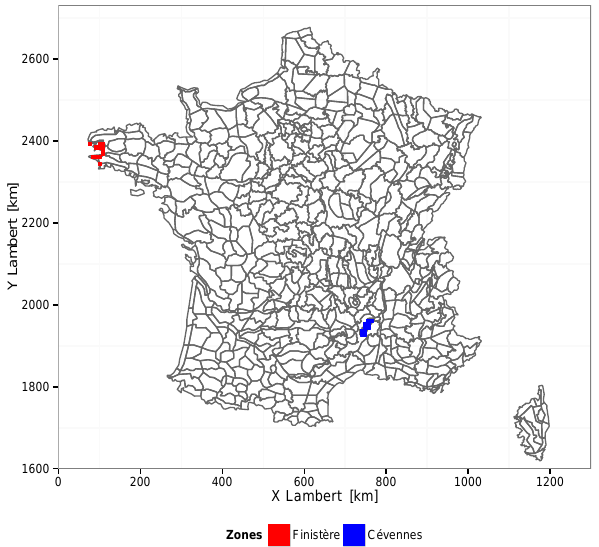
Figure 2. Map of the 608 climatologically homogeneous zones de- fined in the Safran data set. Coloured zones highlight case study zones used in Sect. 4: Finistère in Brittany and Cévennes in the Massif Central mountain range.